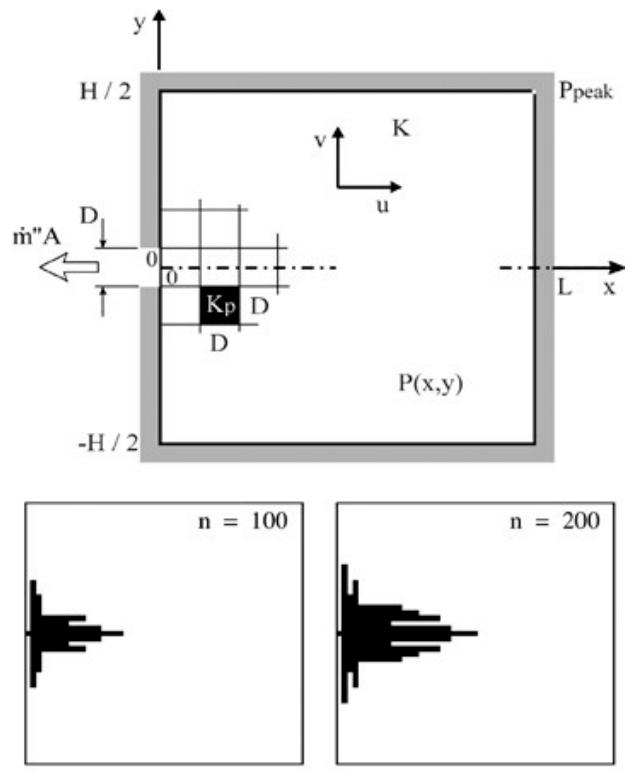
Figure 11. The evolution of a river drainage basin in an erodible porous medium [132]. In time, the flow carves its own river basin, and as a consequence the whole area flows more easily. In three dimensions, the same evolutionary design consists of one tree flow matched to another tree flow, or the modular flow architecture that bathes a volume with one stream that enters from one point and exits from another point (Figure 12) [133,134]. Additional drawings and applications are discussed in Refs.